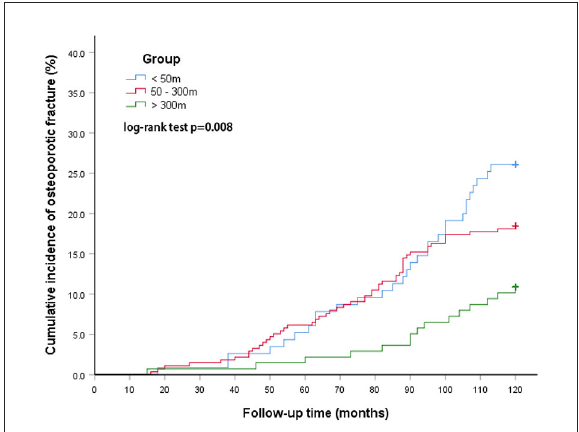
FIGURE3 The cumulative incidence of osteoporotic fractures between groups at different distances from the main